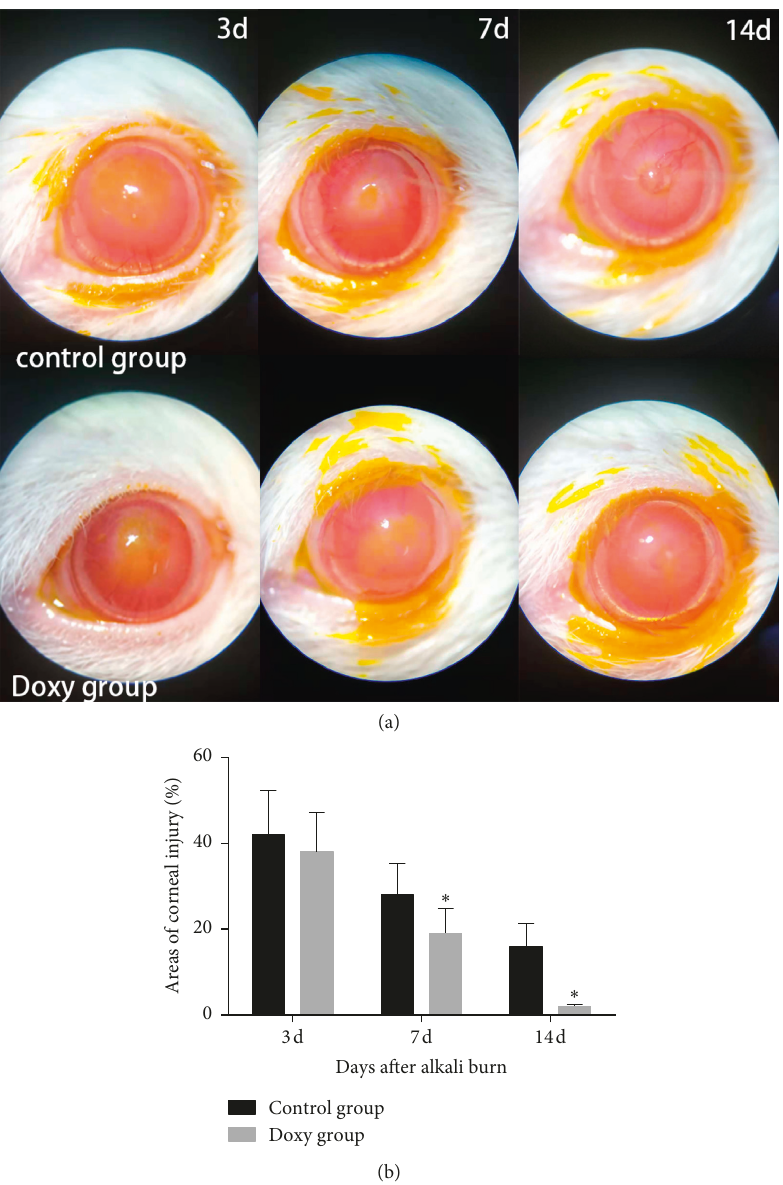
Figure 2: (a) Slit-lamp photographs of fluorescein-stained corneas in the doxycycline group and the control group 3, 7, and 14 days after corneal alkali burn. (b) The corneal epithelial defect areas percentage of two groups on days 3, 7, and 14 after corneal alkali burn. There was a significant difference on days 7 and 14 after corneal alkali burn between two groups ( P < 0 . 05). ∗ Statistically significant; data are expressed as mean ± SD, n �